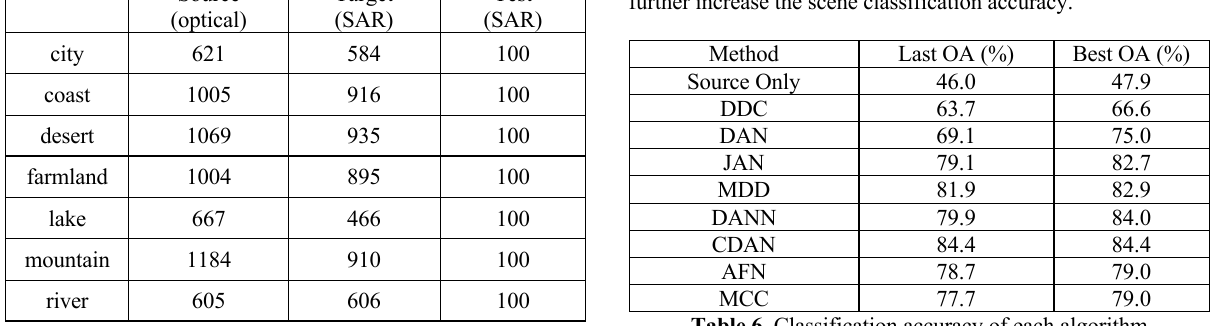
Table 4 . Division of MRSSC dataset eight baseline DA methods are the same and shown in Table 5.